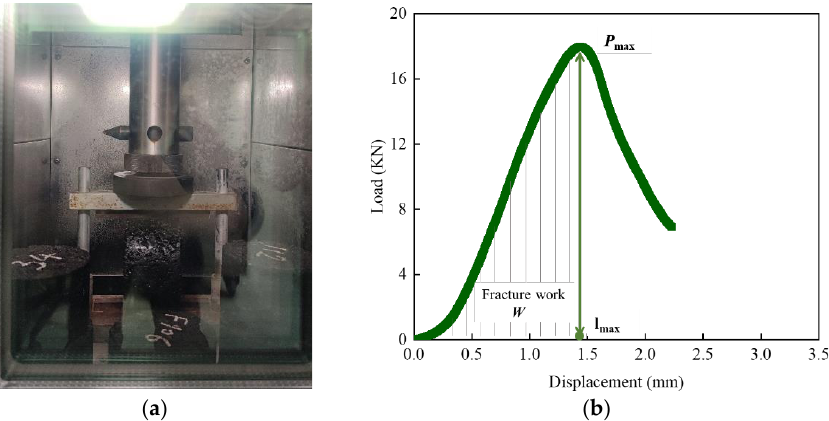
Figure 6. The process and loading curves of IDT test: ( a ) the test process; ( b ) the load-displacement curve.